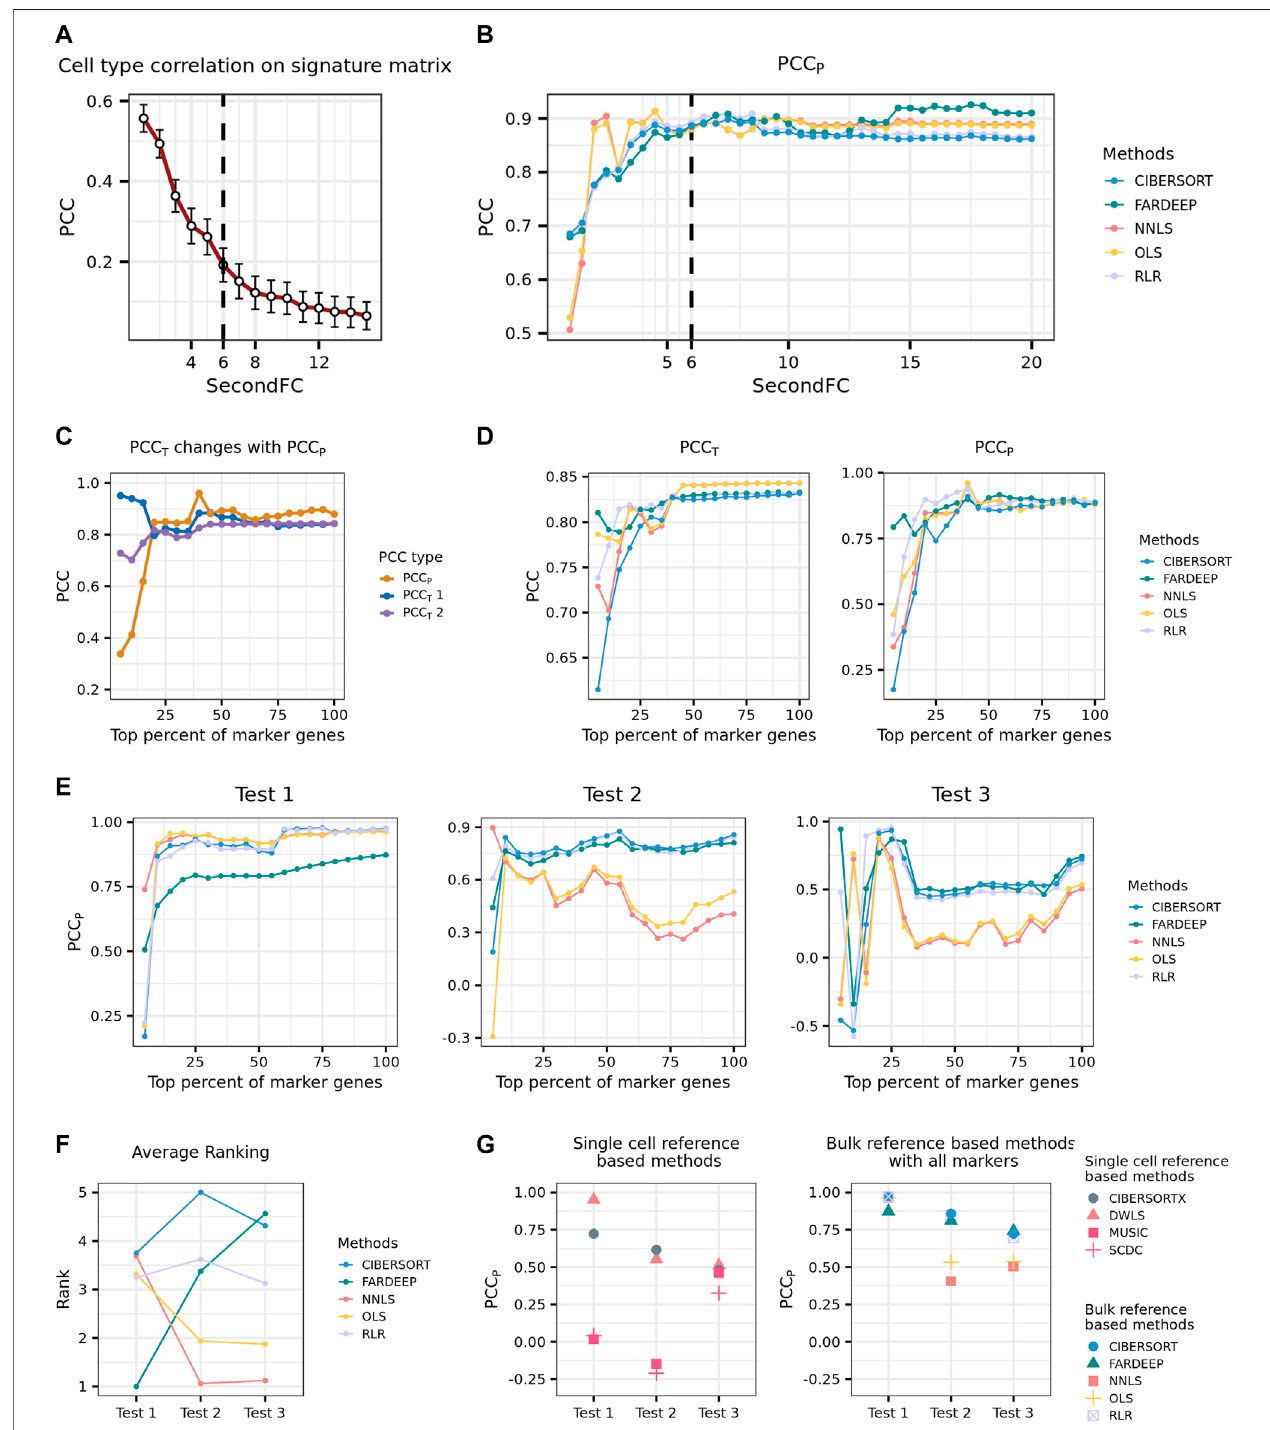
FIGURE 1 | Development of a practical pipeline for the deconvolution of placenta microarray data. (A) Average PCC on PBMC signature matrix changing with SecondFC cutoff. (B) PCC p ofdifferentmethodschangingwithSecondFCcutoff. (C) ThechangesofPCC T andPCC p ,wherethepredictedexpressionpro fi lesoftheformerandthelatterwere computedbyusingtheinputsignaturegenematrixvaried.PCC T1 andPCC T2 arethePCCbetweenthepredictedandtherealbulkexpressionpro fi lesoninputtedsignaturegene matrixandthesignaturegenematrixwithallmarkergenes,respectively. (D) ThechangesofPCC T andPCC p byusingdifferentdeconvolutionmethods,wherePCC T refersto PCC T2 in (C) . (E) Three benchmark tests to evaluate the performance of different deconvolution methods. In Tests 1 and 2, the reference expression pro fi les were from the 10X scRNA-seq PBMCdatageneratedbyDingetal.(2020), and thebulk datawereFinotello ’ sPBMCRNA-seq dataand Newman ’ sPBMCmicroarraydata.In Test3,thebulk data werethesameasinTest2,whilethereferenceexpressionpro fi lesweretheDrop-seqandinDropsscRNA-seqPBMCdatageneratedbyDingetal.(2020) (F) Theaveragerankof differentdeconvolutionmethodsacrossthethreetestsin (E) . (G) Thecomparisonoftheperformanceofsingle-cellandbulkreference-basedmethodsacrossthethreetestsin (E) .